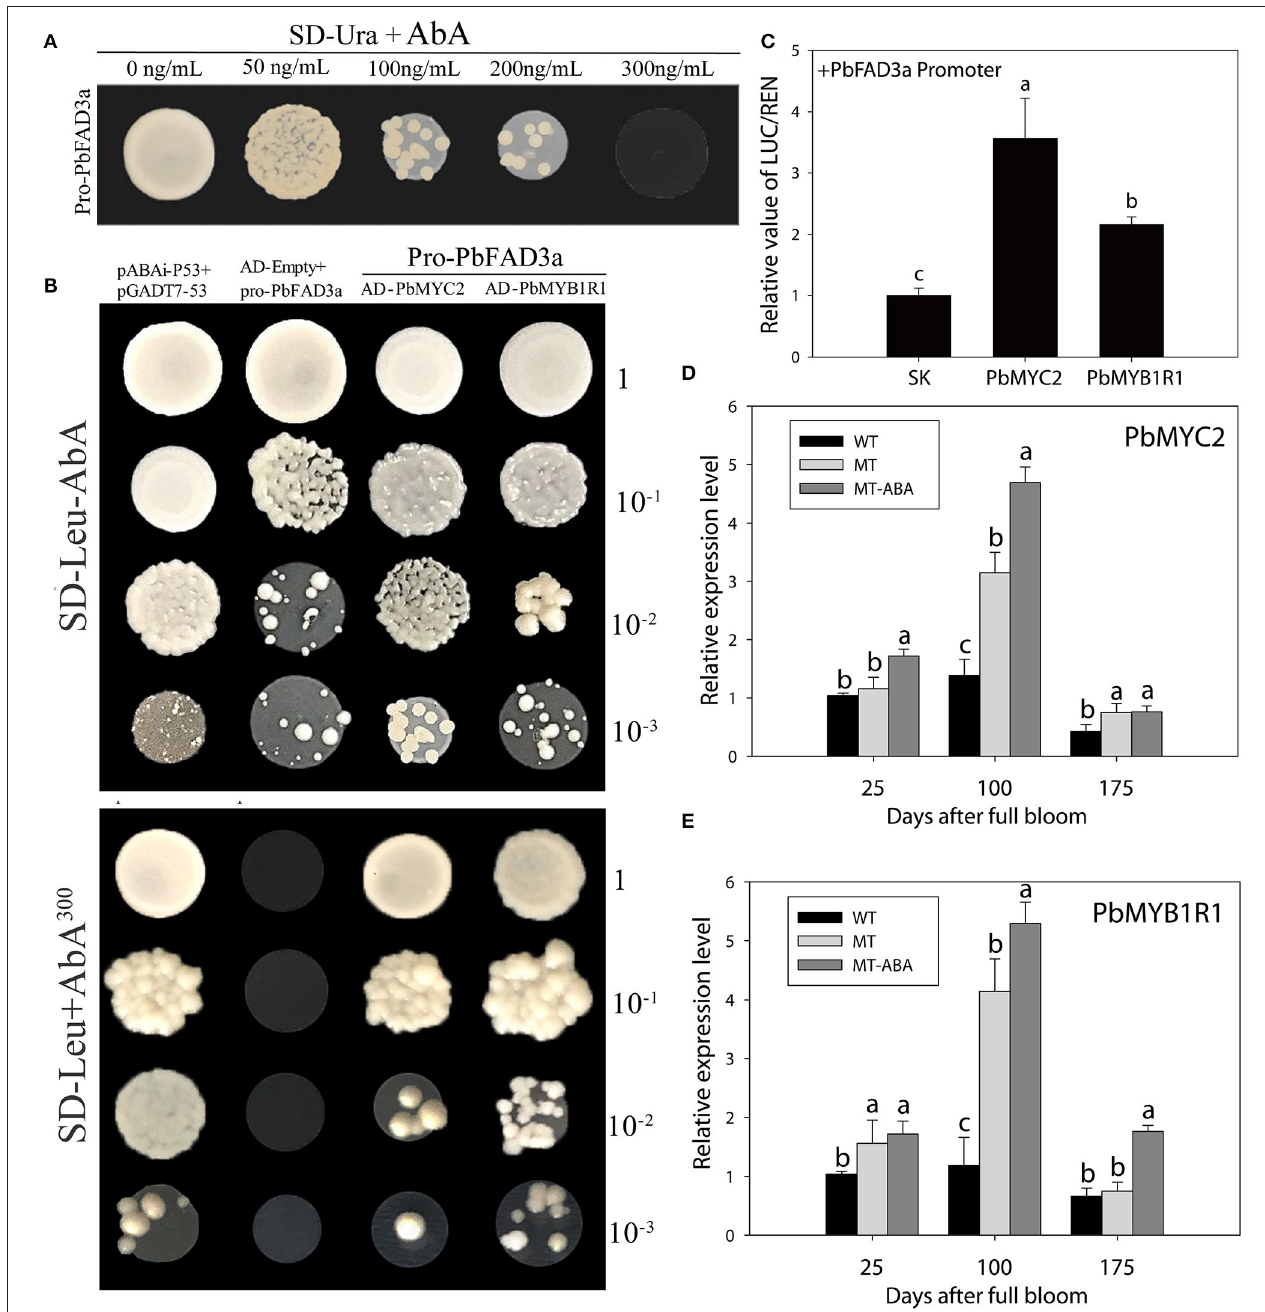
FIGURE 11 | MYB1R1 and MYC2 are induced by ABA and bind to the PbFAD3a promoter to activate its expression. (A) Screening of ABA concentration. (B) Y1H assays. AD-53 was co-transformed with the pAbAi-p53 to Y1HGold as positive control, while AD-empty and pro-PbFAD3a-AbAi were used as negative controls. (C) Dual luciferase assays demonstrating that MYC2 and MYB1R1 activate the PbFAD3a promoter. The ratio of LUC/REN of the empty vector (SK) plus the promoter was used as the reference (set as 1). (D) qRT–PCR analysis of PbMYC2 (D) and PbMYB1R1 (E) after ABA treatment. Pro, promoter. The error bars are the means ± SD of three biological repeats and lowercase letters indicate significant differences by two-tailed Student’s t -test ( p < 0.01).